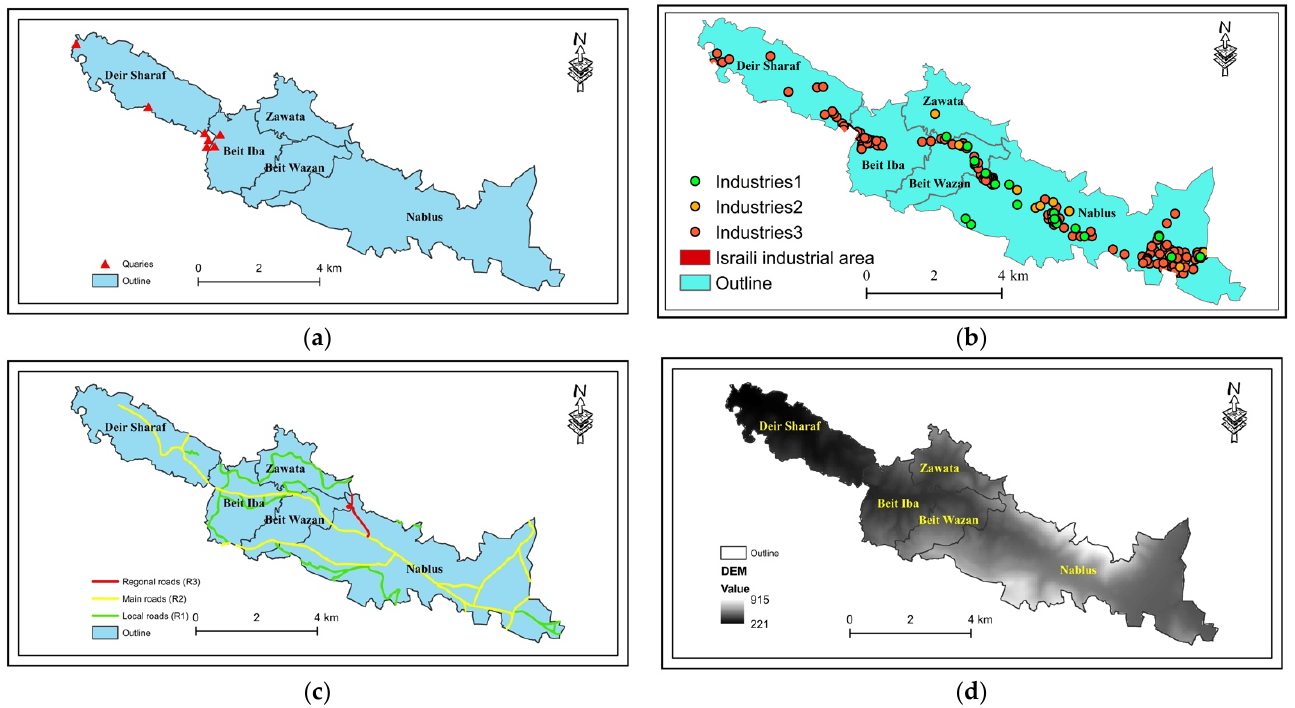
Figure 2. Location of potential PM emission sources in the study area: ( a ) quarries; ( b ) industries; ( c ) roads; and ( d ) topography of the study area.